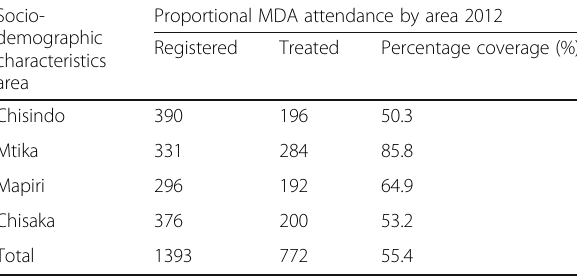
Table 2 MDA Coverage Rate by Area in 2012 Socio-